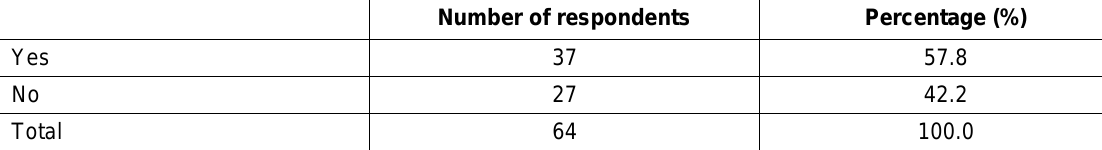
Table 7: Awareness of how SCC decisions are made (general public)